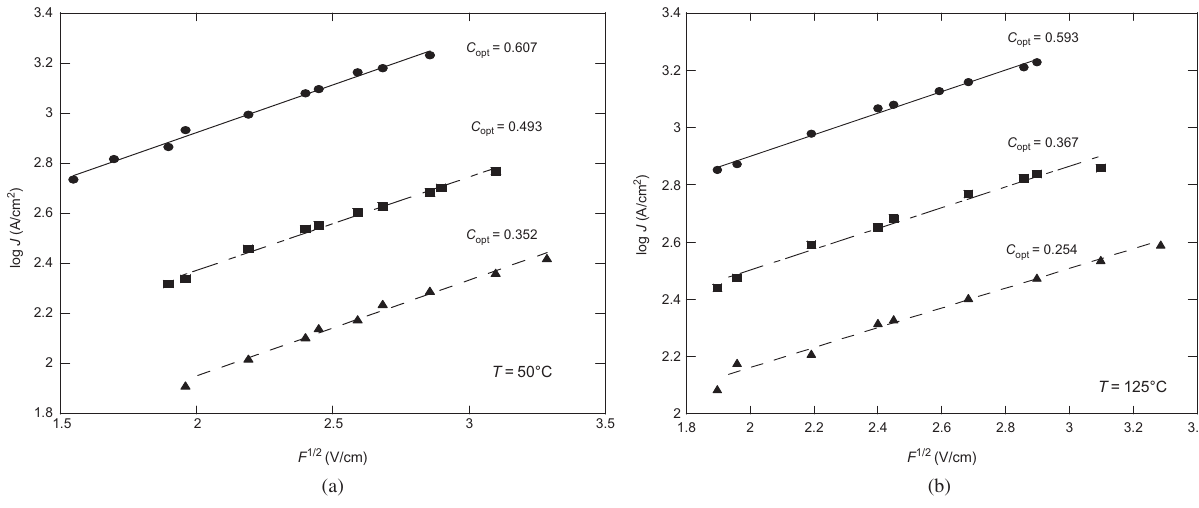
Figure 4: Log J vs F 1/2 at various C opt concentrations for two different substrate temperatures.